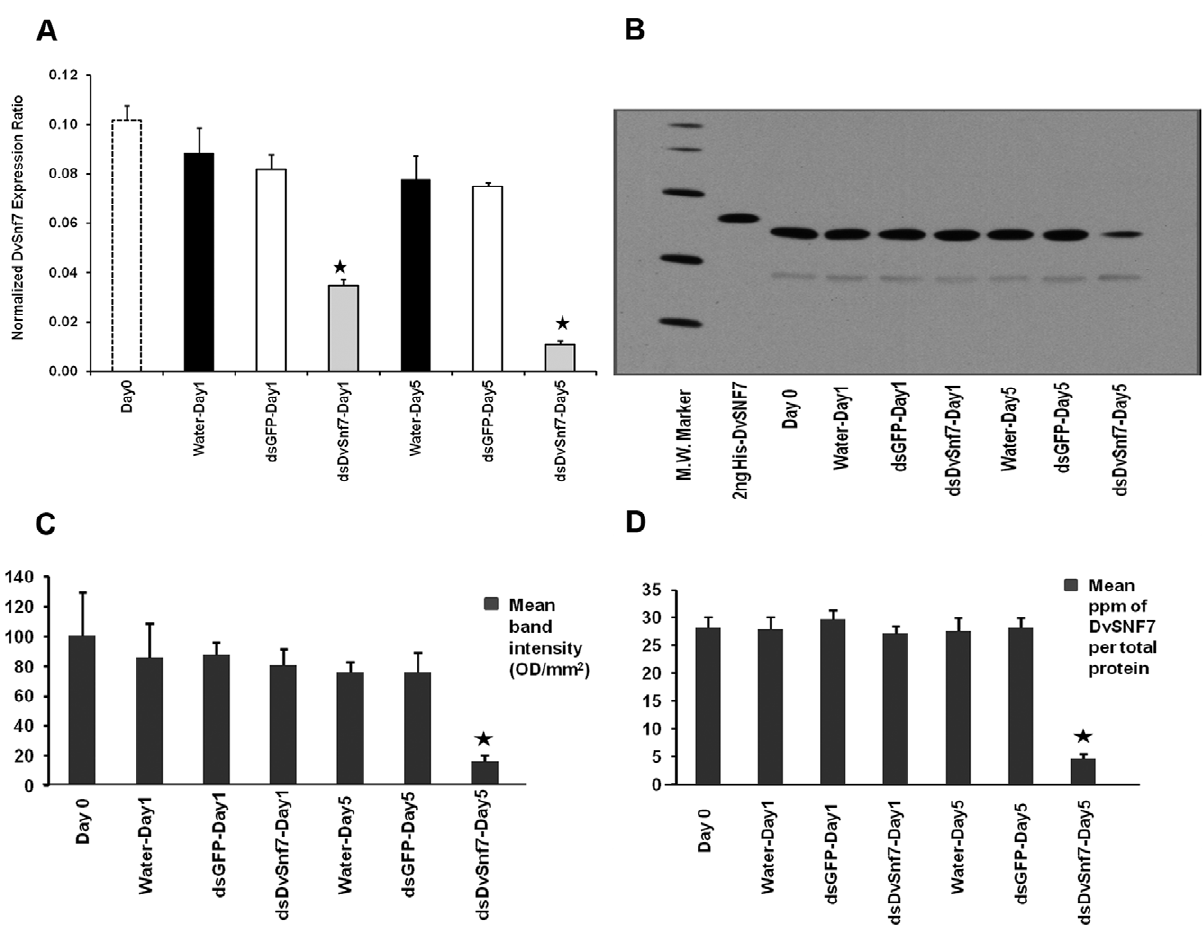
Figure 3. DvSnf7 mRNA and DvSNF7 protein suppression by RNAi. DvSnf7 dsRNA causes suppression at mRNA (A) and protein (B–D) levels in Western Corn Rootworm (WCR, Diabrotica virgifera virgifera ). (A) Real-time RT-PCR results showing significant decrease in DvSnf7 mRNA expression in insects fed with 60 ng/mL of DvSnf7 240 bp dsRNA continuously for one and five days. Insects fed with control diets containing water or GFP dsRNA do not show mRNA suppression. (B) Western blot results using anti-SNF7 antibody showed DvSNF7 protein suppression in insects fed with DvSnf7 240 bp dsRNA after 5 days, which was confirmed by quantification of the Western blot by densitometry (C) as well as ELISA (D). Stars represent values significantly different from controls (p=0.05;